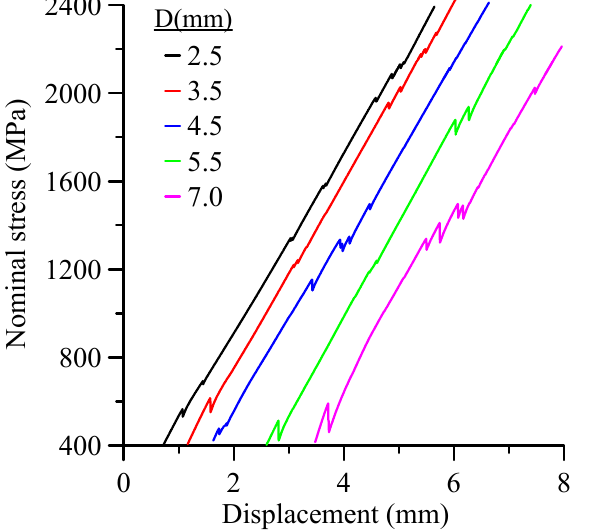
Figure 13. The change in the number and amount of stress relaxation with hole diameter.